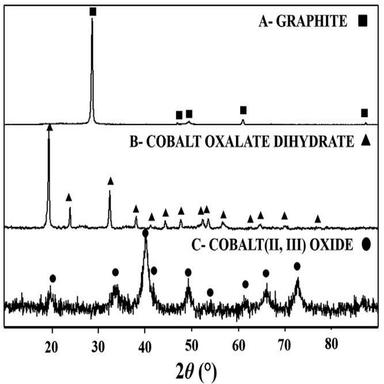
XRD patterns of graphite (pattern A), Co3O4 (pattern B) and CoC2O4·2H2O (pattern C).